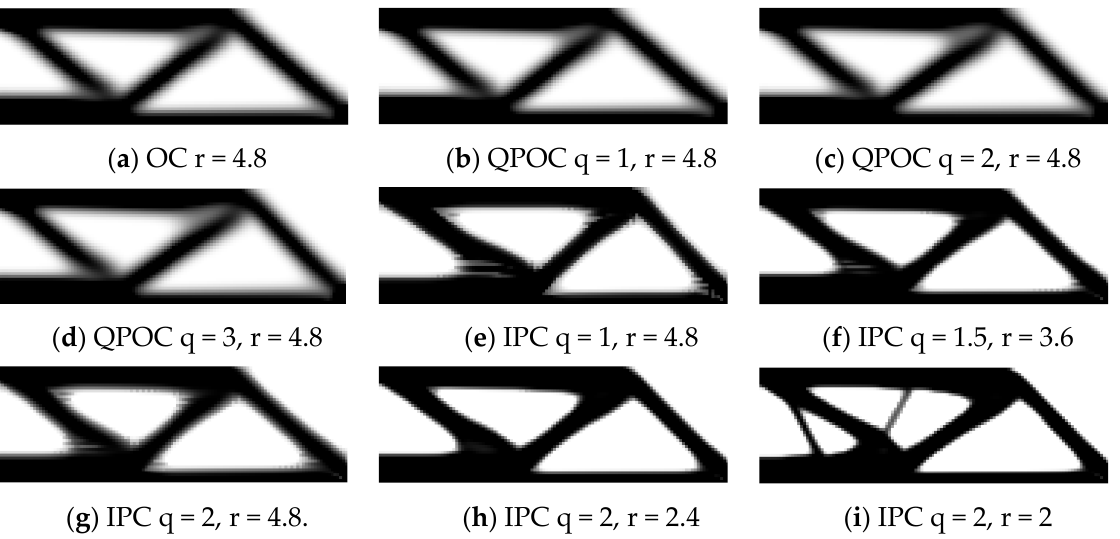
Figure 2. Design domain of the MBB beam.